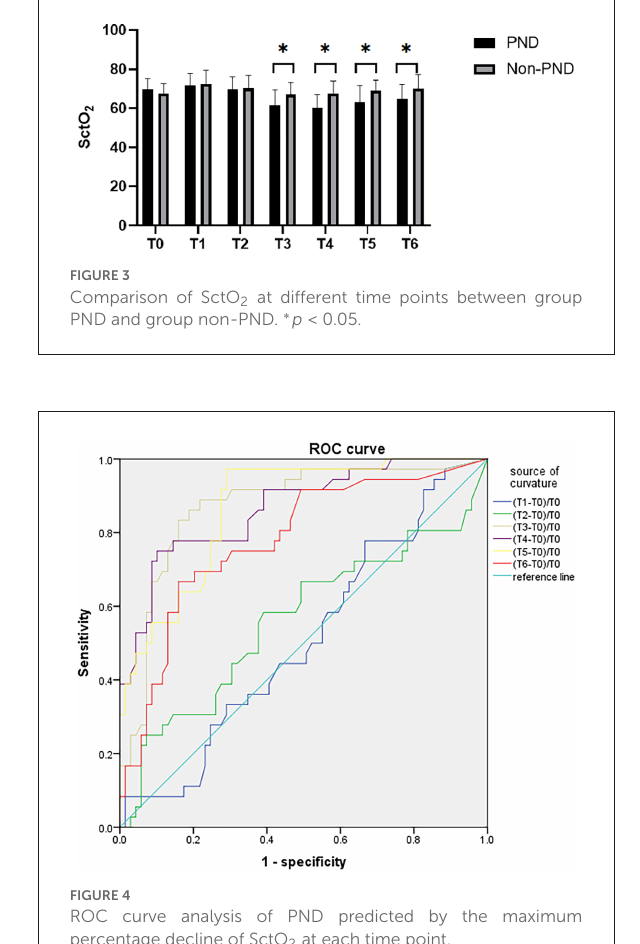
Spinal surgery is performed in the prone position accompany a variety of hemodynamic and respiratory alterations. Deiner and colleagues indicated that elderly spine surgery patients in the prone position were more than twice as likely to experience mild cerebral desaturation as patients in the supine position (Deiner et al., 2014). Notably, it is essential to monitor SctO 2 in the prone spinal surgery. In our study, elderly patients undergoing spinal surgery were selected as